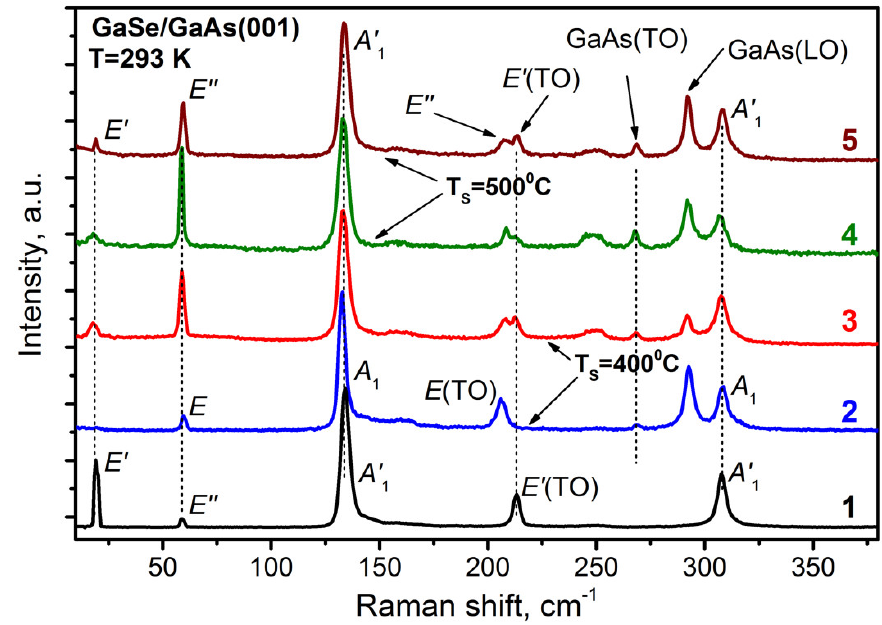
Figure 6. Raman spectrum of the bulk ε-GaSe layer produced by HQ Graphene (Curve 1). Raman spectra of the GaSe layers grown on GaAs(001) substrates at T S ~400°C (Curves 2 and 3, samples # GS1 and # GS8 , respectively), at T S ~ 500°C (Curve 5, sample # GS7 ), and using a two-stage growth mode (Curve 4, sample # GS3 ). All spectra are normalized to the intensity of the A 1 phonon line (132 cm −1 ).